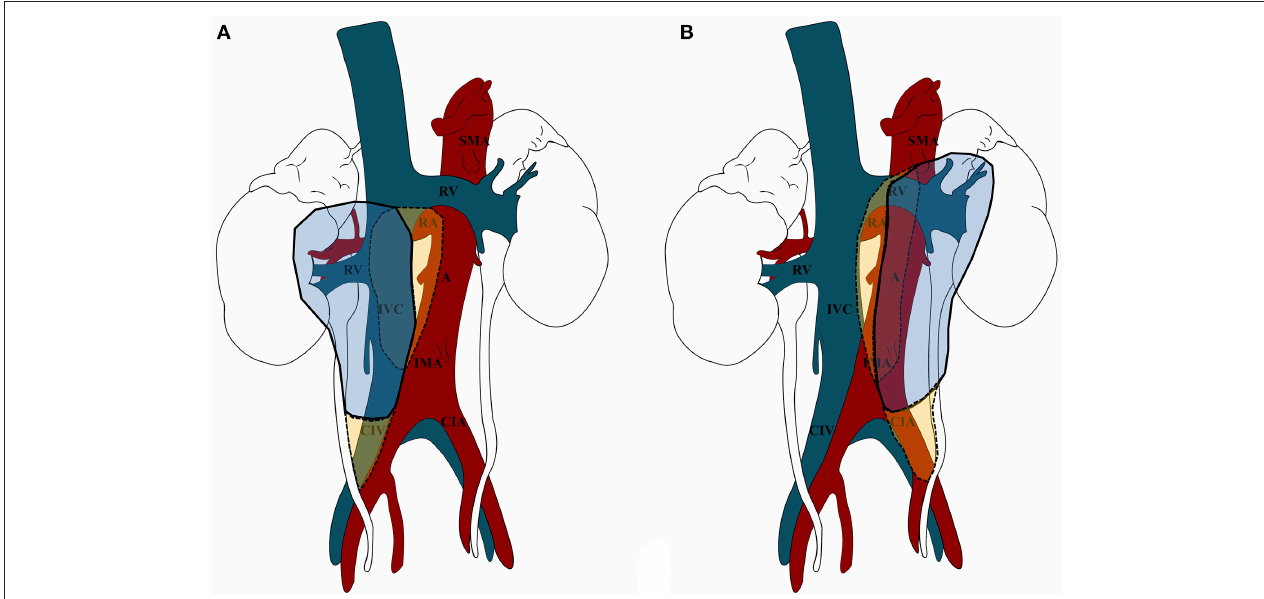
FIGURE 1 | Overview of the most commonly dissected templates of lymph node dissection (LND) for renal cell carcinoma (RCC) according to tumor side (A. Right-sided tumors; B. Left-sided tumors). (A) For right-sided tumors, LND included in most cases (continuous line) the renal hilar, paracaval, and precaval nodes, from the crus of the diaphragm to the aortic bifurcation ( in blue ). Extended LND (dotted line) also included the inter-aortocaval/retrocaval nodes and the right common iliac nodes ( in yellow ). (B) . For left-sided tumors, LND included in most cases (continuous line) the renal hilar, preaortic, and paraaortic nodes, from the crus of the diaphragm to the aortic bifurcation (in blue ). Extended LND (dotted line) also included the inter-aortocaval/retroaortic nodes and the left common iliac nodes (in yellow ). A, aorta; CIA, common iliac artery; CIV, common iliac vein; IMA, inferior mesenteric artery; IVC, inferior vena cava; RA, renal artery; RV, renal vein; SMA, superior mesenteric